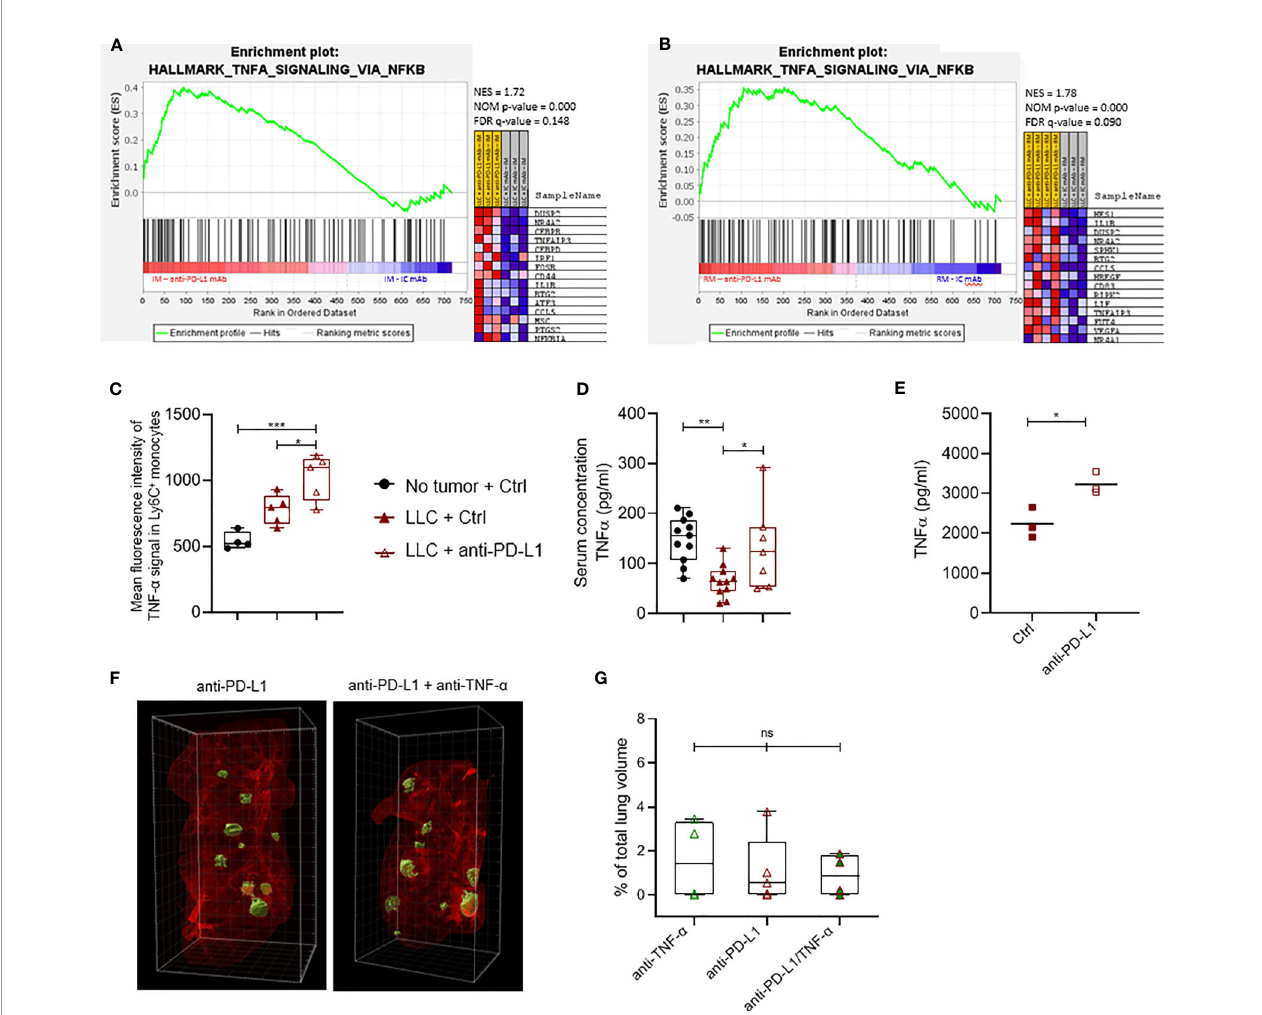
FIGURE 4 | Anti-PD-L1 therapy induces a TNF- a -linked response in monocytes. Three weeks after LLC engraftment, lungs from anti-PD-L1 or Ctrl mAb-treated mice were isolated and pooled to sort minimally 50k Ly6C + and CX3CR1 + monocytes. Subsequently, RNA was isolated to perform targeted gene expression pro fi ling using the Nanostring platform. (A, B) Gene set enrichment analysis ranking genes using the MSigDB Hallmark gene set collection for Ly6C + and CX3CR1 + monocytes resp. with NES, NOM p-value and FDR q-value denoted on the graphs. On the right, the top 15 gene set members on the rank ordered list are